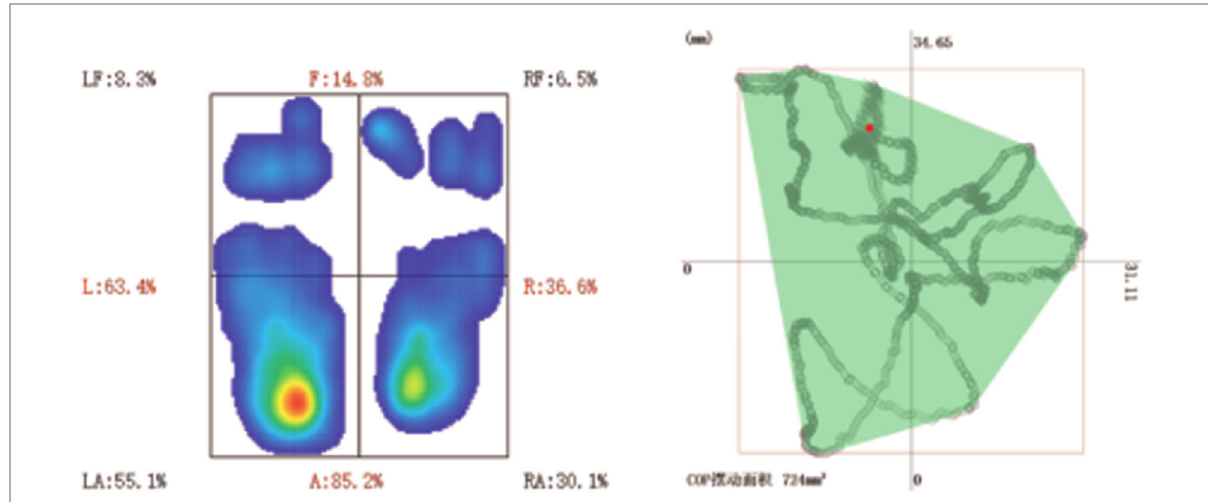
FIGURE 2 Plantar pressure data analysis: percentage of pressure load in each area of the foot (left) and pressure center (COP) swing area (right).